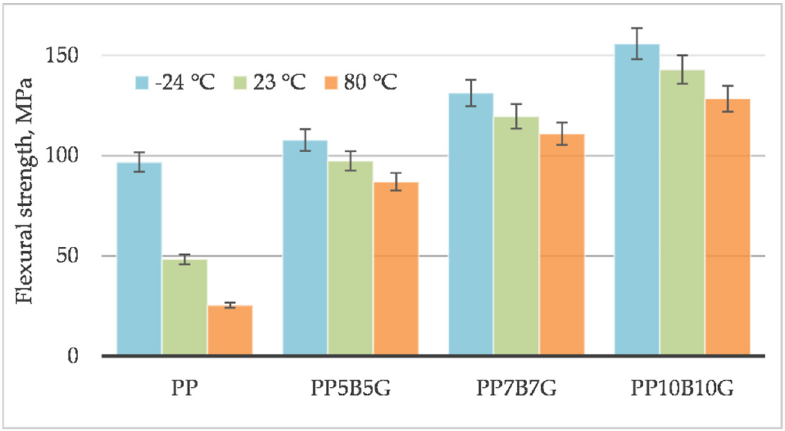
Figure 12. Unnotched Charpy impact strength of basalt/glass polypropylene composites at − 24 °C, 23 °C and 80 °C.